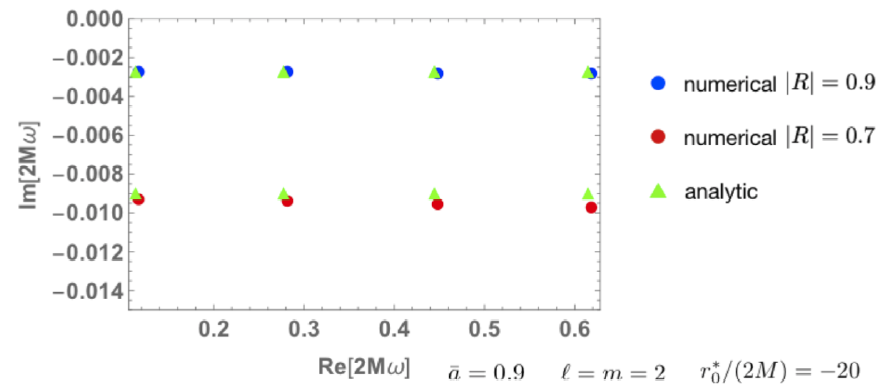
= 0.7 (red filled circles) and 0.9 (blue filled circles), r ∗ R | |